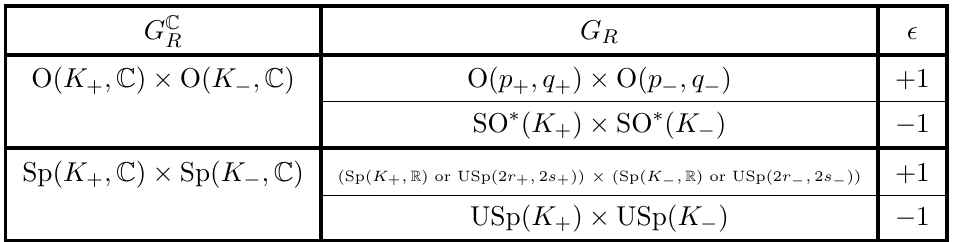
Table 5. Here we list the real R-symmetry groups which can occur in orthogonal Weyl-compatible signatures. Note that p (cid:15) -quaternionic structure on S is correlated with a given real form of the complex R-symmetry